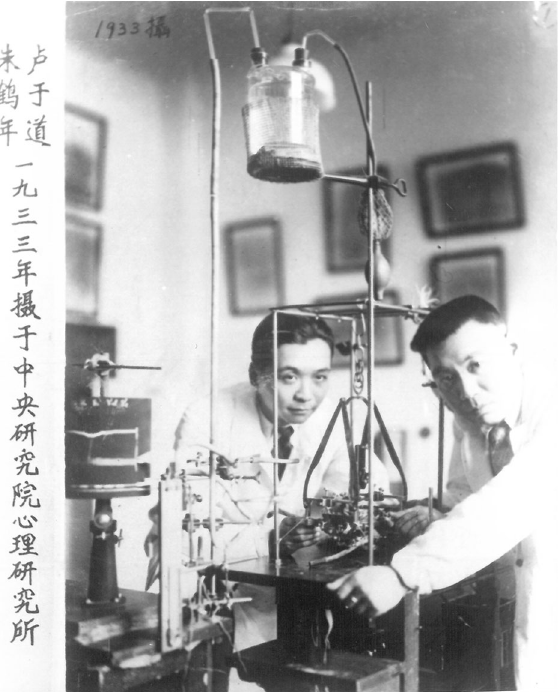
Figure 1. Dr. Yu-tao Loo (from left) with his colleague Dr. Ho-nien Chu (from right) in